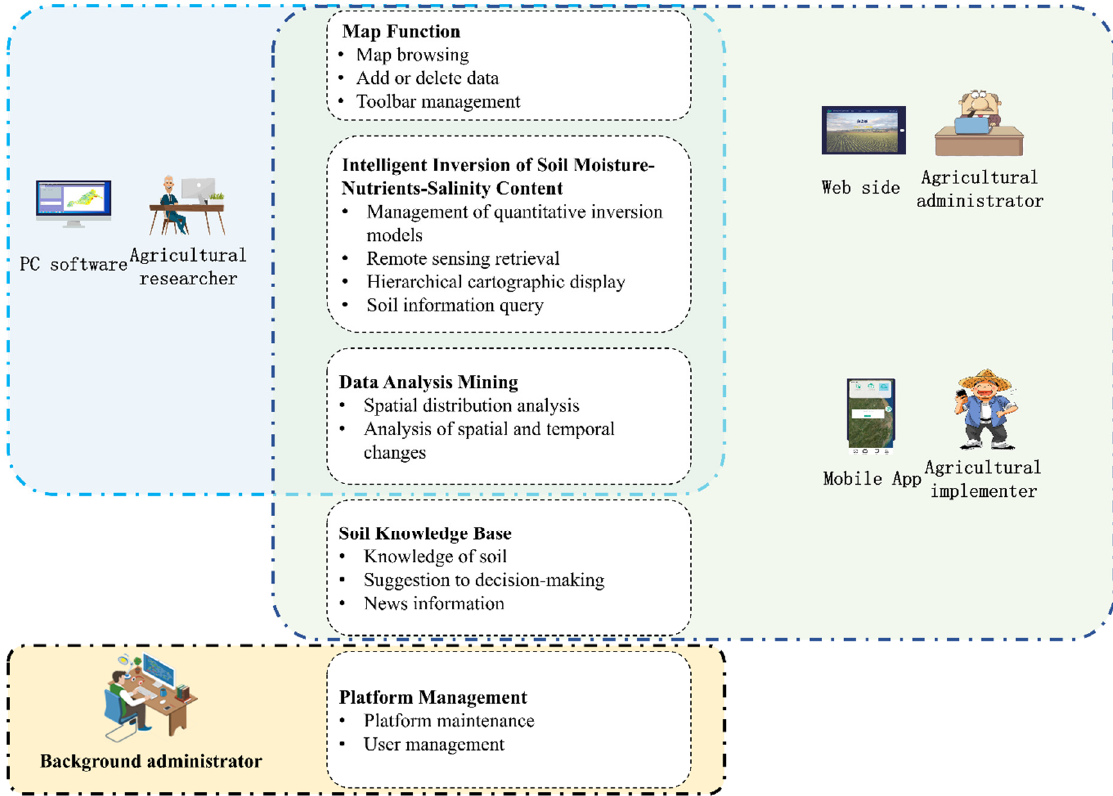
Figure 3. System function module